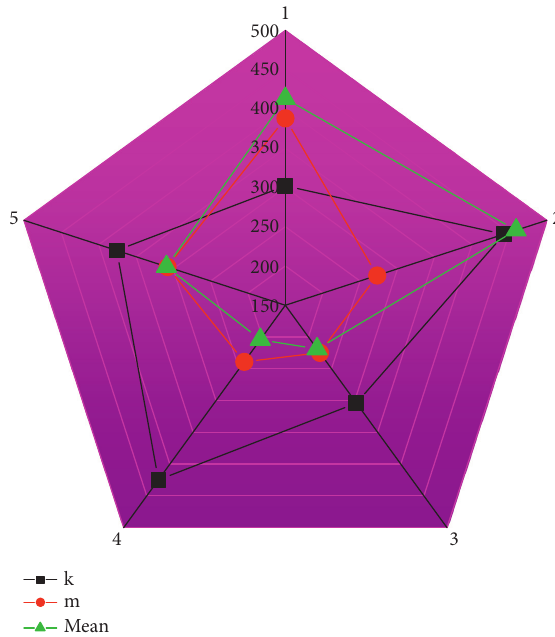
Figure 10: The best five sets of experimental parameter values and experimental